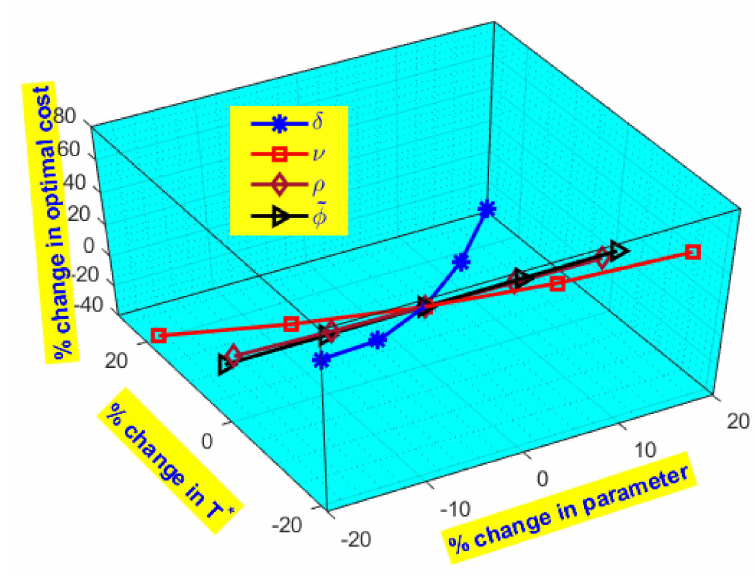
Figure 10. Variations in optimal cost due to changes in system